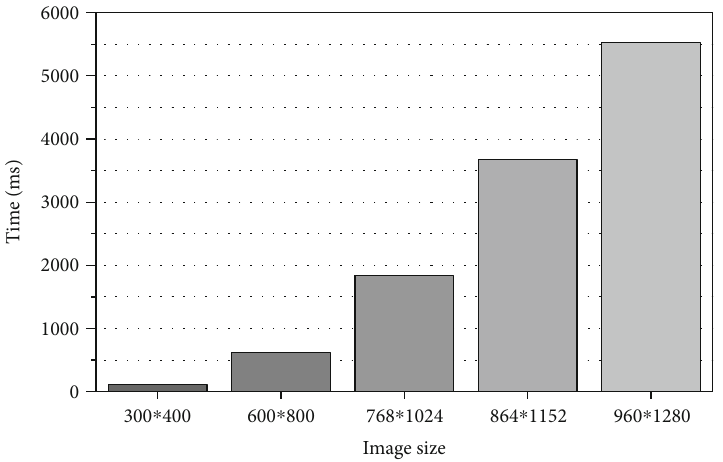
Figure 4: Time required to extract image singular values.